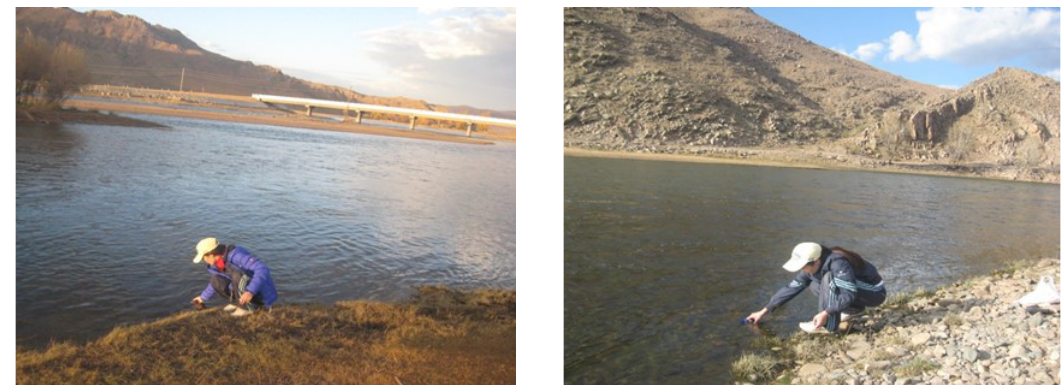
Figure 3. Upstream (right) and downstream (left) of Ider River. Photo by A.Orkhonselenge.